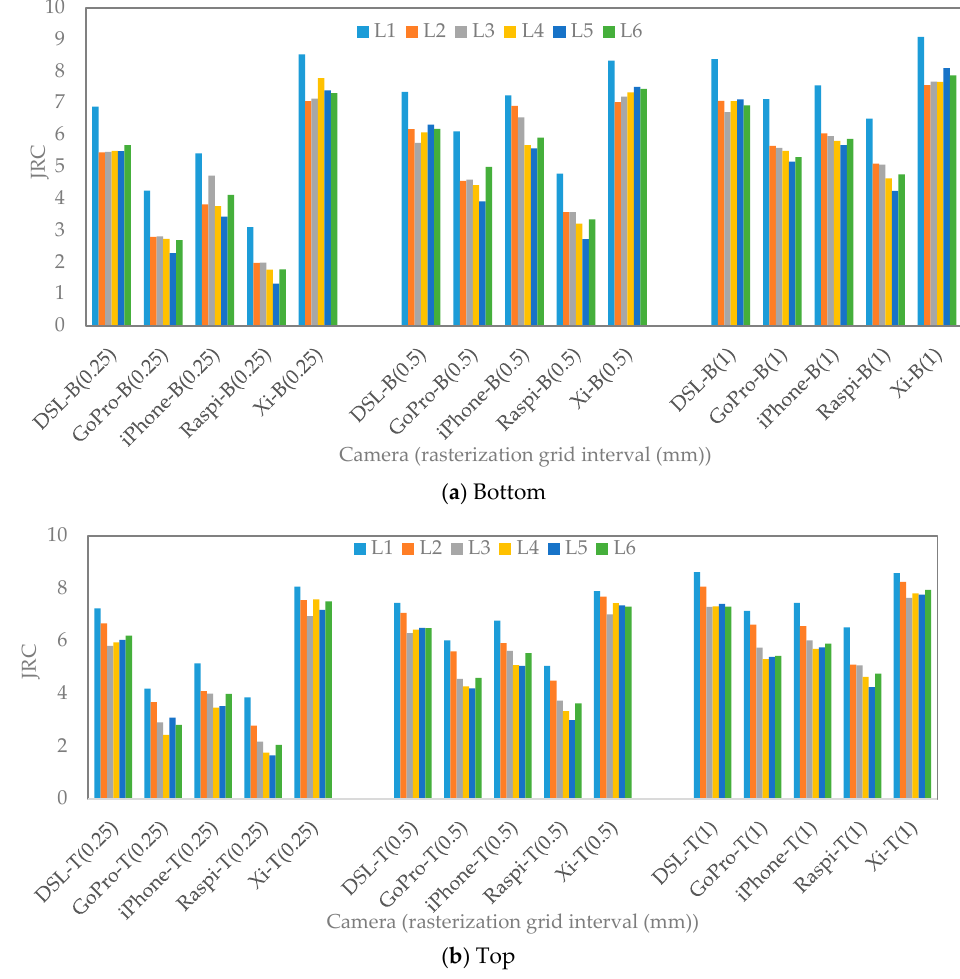
Figure 12. JRC values with different rasterization grid intervals obtained by different cameras alongside the 2D profiles (L 1 to L 6 ).